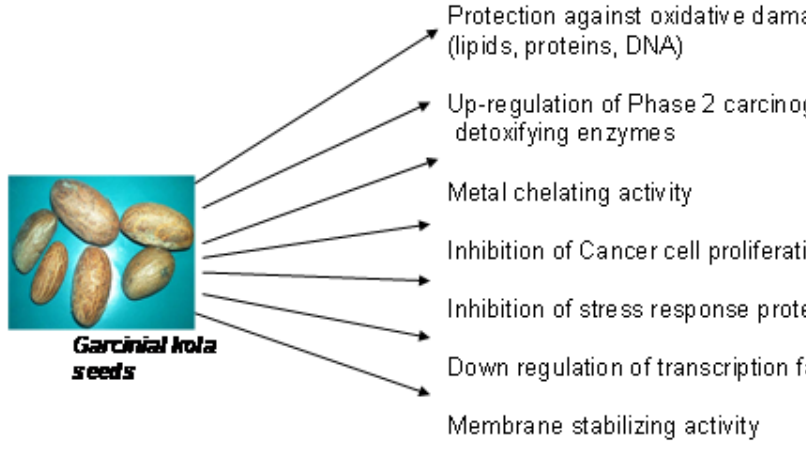
Figure 6. Biochemical mechanisms underlying chemopreventive properties of Garcinia kola